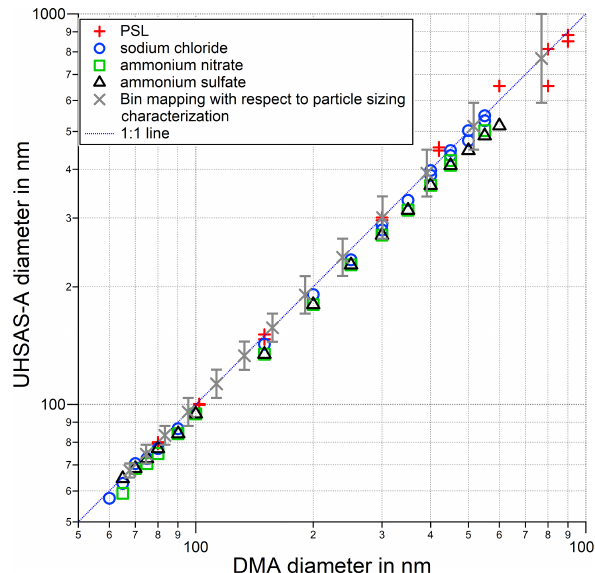
Figure A3. Characterization measurements for the particle sizing of the UHSAS-A: main particle mode diameter of the size distribution measured by the UHSAS-A (using all 99 available size bins) com- pared with the particle diameter selected by a DMA for different particle species. The gray bars represent the bin mapping used after post-processing.